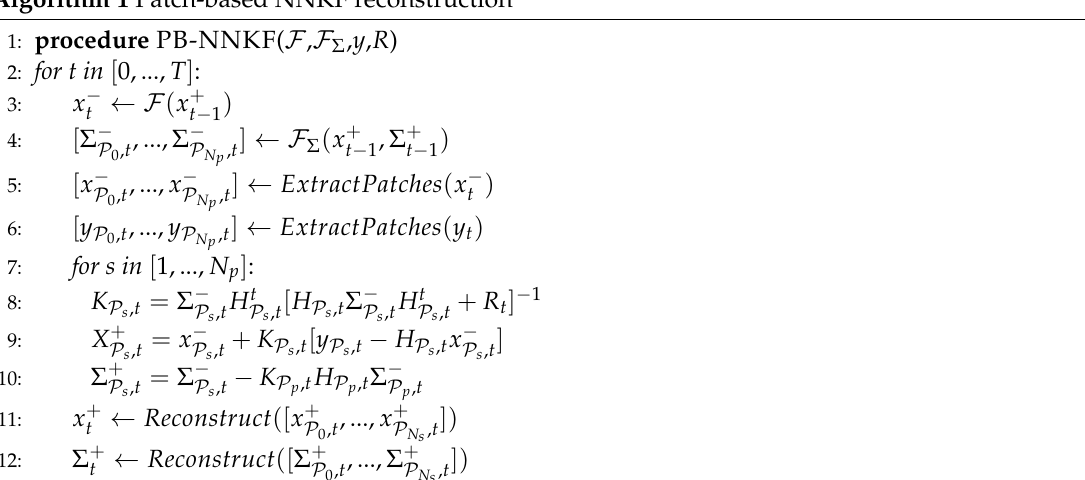
Algorithm 1 Patch-based NNKF